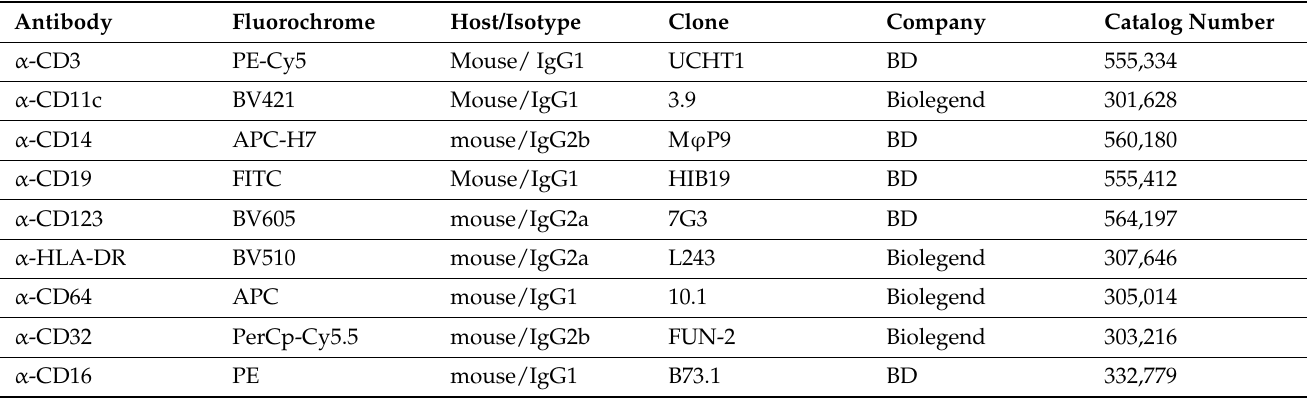
Table 1. Antibody panel used for peripheral blood mononuclear cell (PBMC) phenotyping and assessing the expression of Fc γ